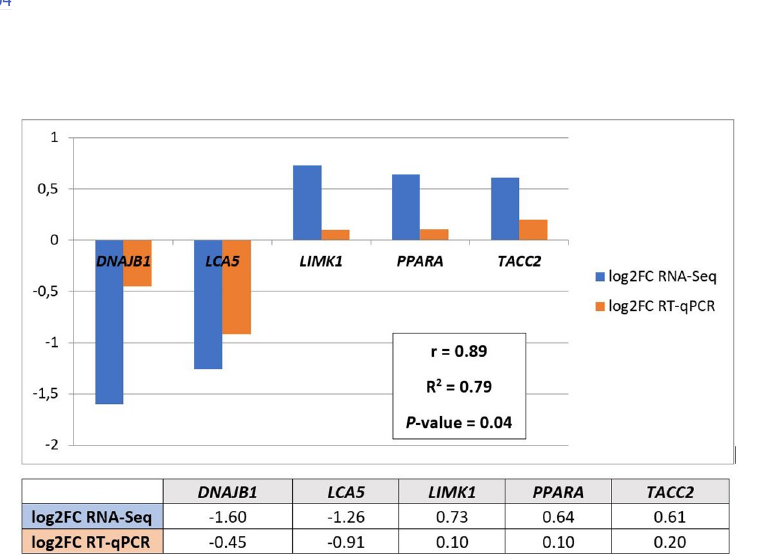
Fig 5. RT-qPCR validation of five genes found differentially expressed by RNA-Seq analysis. The table reports the Log 2 Fold Change of the gene expressions between low IMF and high IMF groups for the RNA-Seq and RT-qPCR. The same values are also graphically presented with the results of the correlation analysis (with the r correlation coefficient, the R 2 coefficient of determination, and the P-